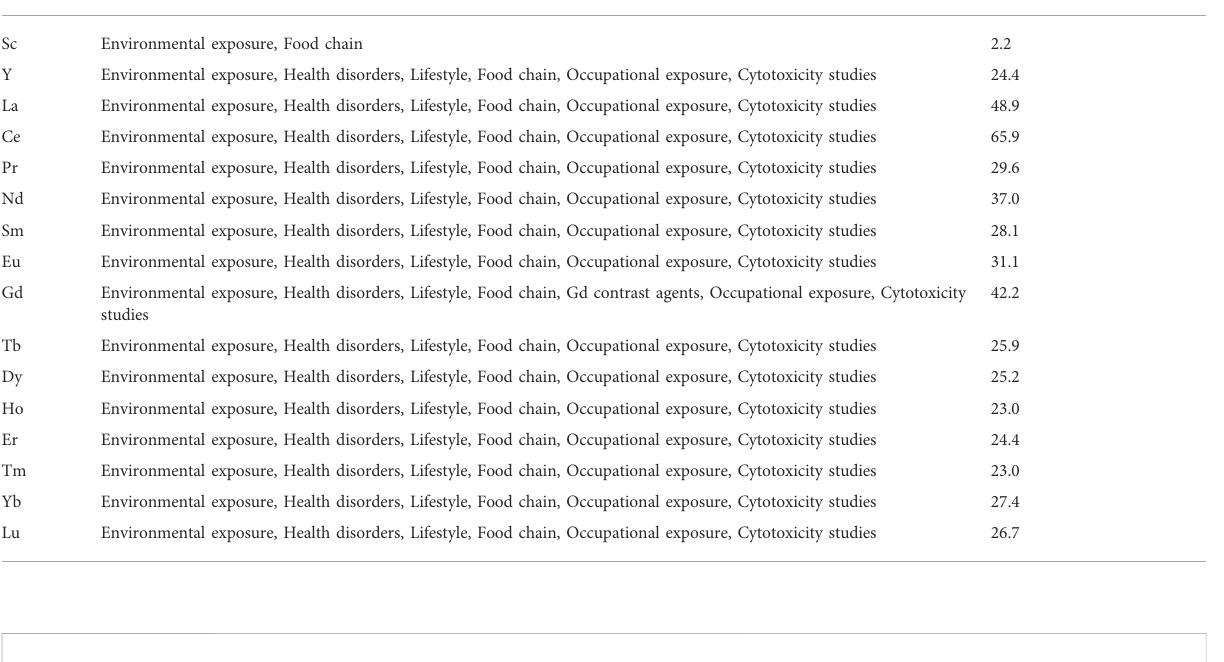
TABLE 1 Schematic summary table demonstrating the different sections that each REE has been studied about at least once, and the relative abundance (%) of papers including information for the toxicity of each REE to human health. Element Sections studied